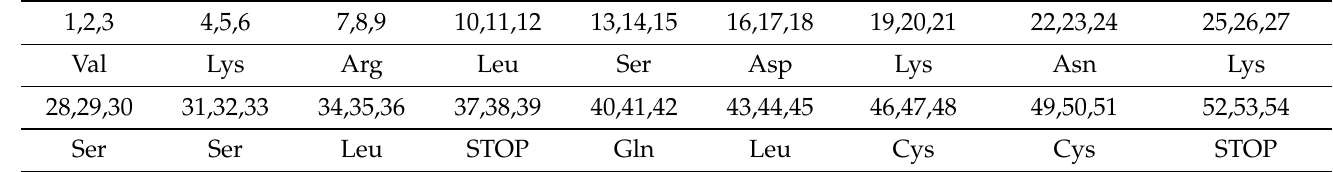
Table 3. The sequence of amino acids corresponding to 54-base-pair-long segment of SATB1.